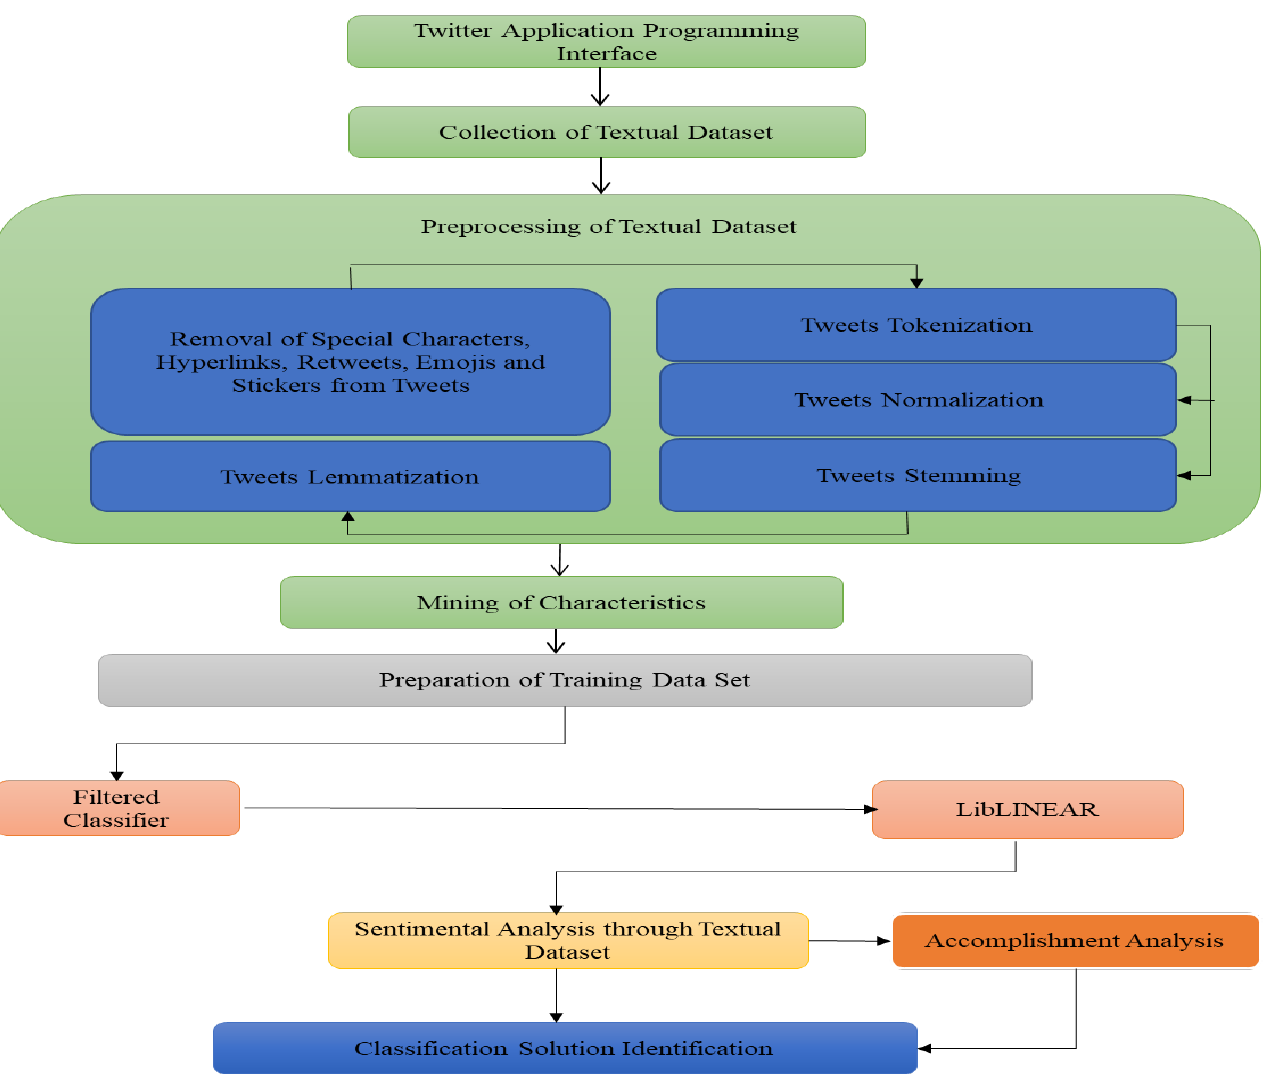
Figure 4. Text-based sentimental classification.